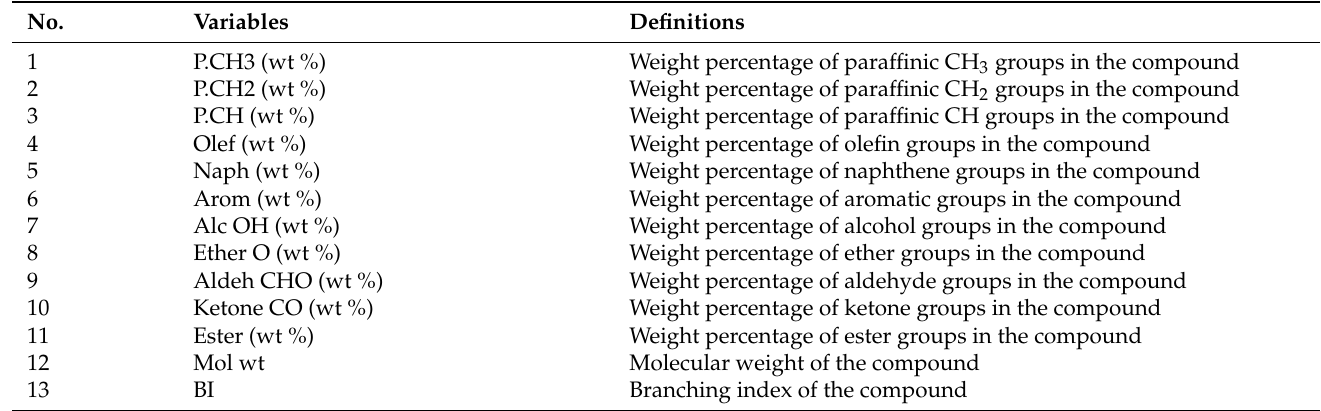
Table 1. Variables, along with their